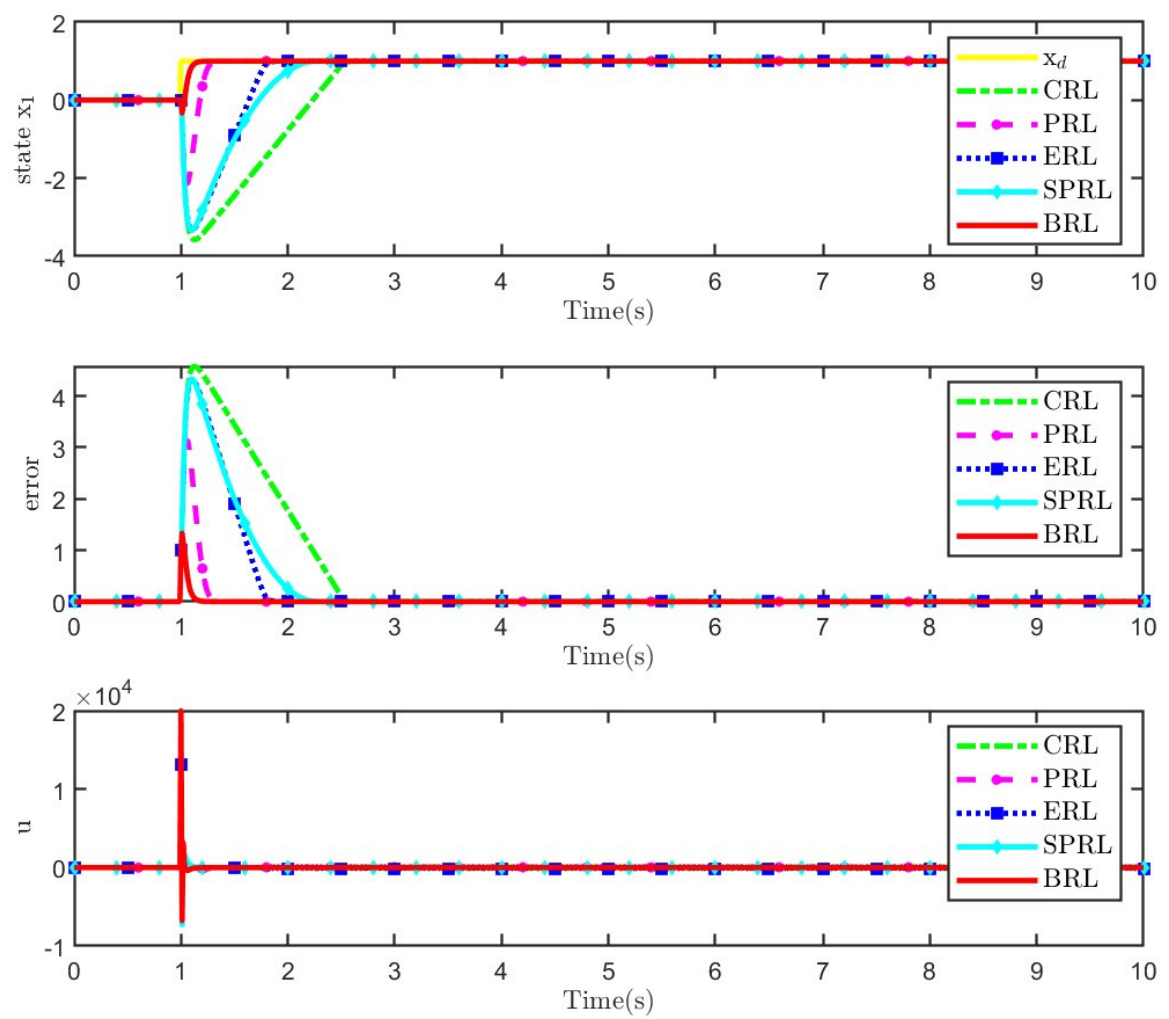
Electronics 2022 , 11 , 2392 Figure 3. Tracking results of different reaching laws under step signals. Figure 3. Tracking results of different reaching laws under step signals.